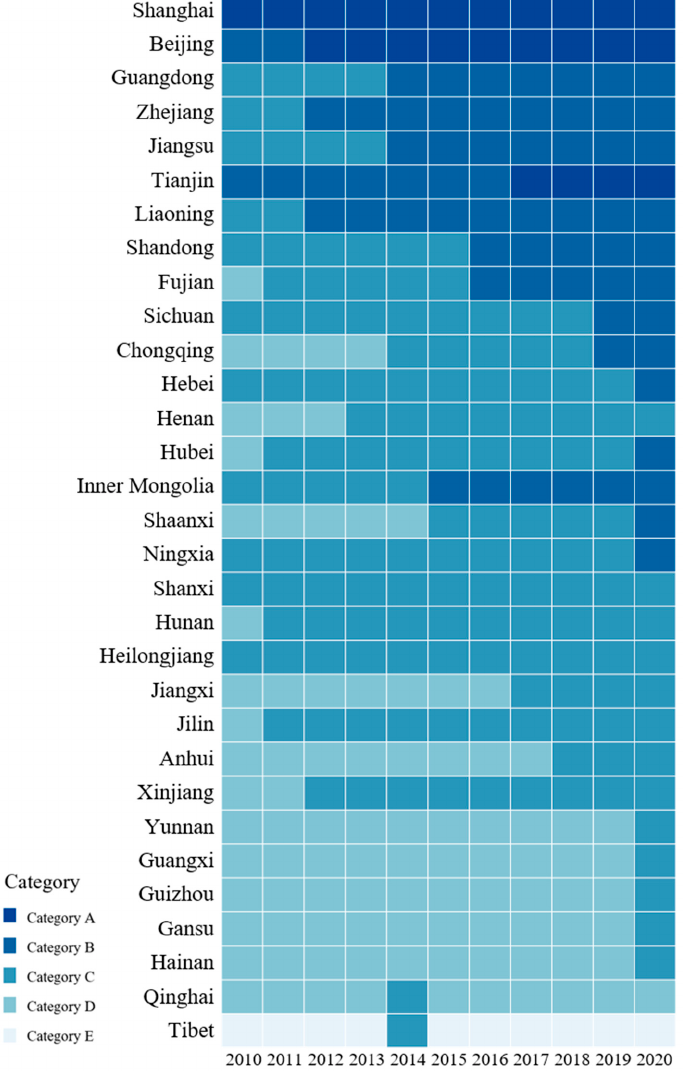
Figure A2. Historical trend of healthy environment categories in different regions. Table A1. KMO and Bartlett’s sphericity test.